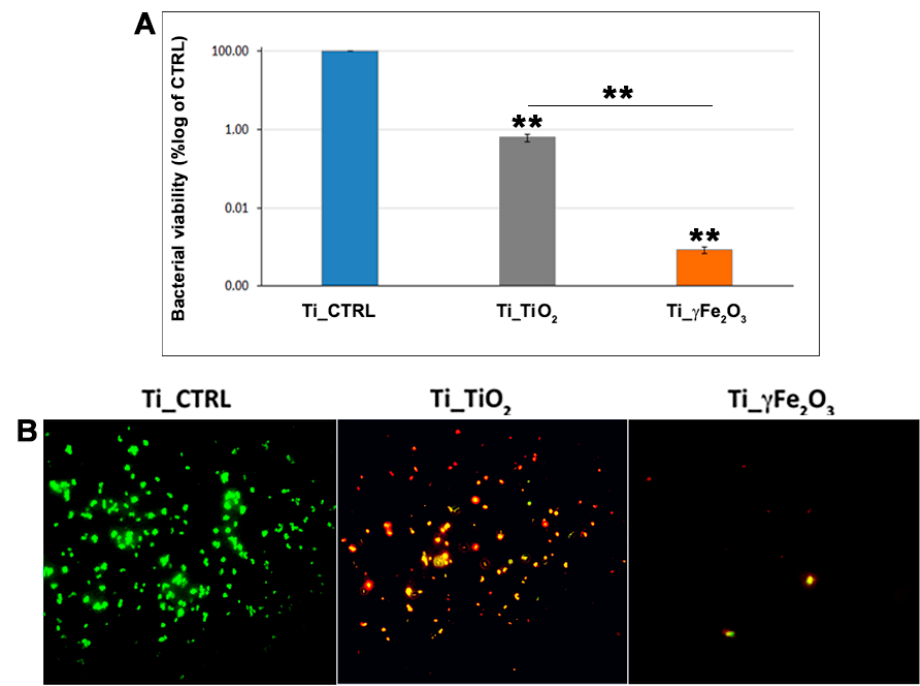
Figure 6. ( A ) CFU assay performed on Ti_TiO 2 and Ti_ γ Fe 2 O 3 scaffolds, compared to the Ti_CTRL, after 24 h of S. aureus bacteria incubation. The data are expressed as CFU average percentage ± standard deviation of six replicates. ** p < 0.01 shows significant differences between the different time points as reported by the Holm post-hoc test. ( B ) Live/Dead staining of the cells adhering to the scaffolds. The green and red stains indicate the presence of live and dead bacteria, respectively.